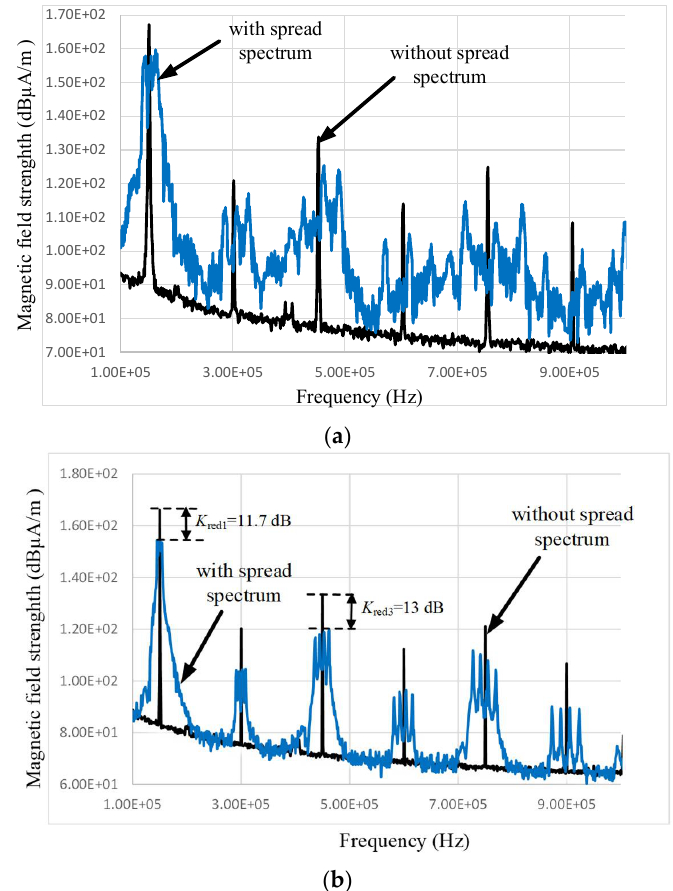
Figure 10. Comparison of spectra of radiated emissions from the WPT system without spread spectrum and with spread spectrum based on multi-frequency technique: ( a ) 3-frequency technique, f m = 2 kHz, f 1 = 140.4 kHz, f 2 = 151.1 kHz, f 3 = 160.3 kHz, Δ f = 20 kHz; RBW = 1 kHz; ( b ) 4-frequency technique, f m = 0.35 kHz, f 1 = 145.3 kHz, f 2 = 148.8 kHz, f 3 = 151.1 kHz, f 4 = 154.3 kHz Δ f = 9 kHz; RBW = 0.1 kHz.